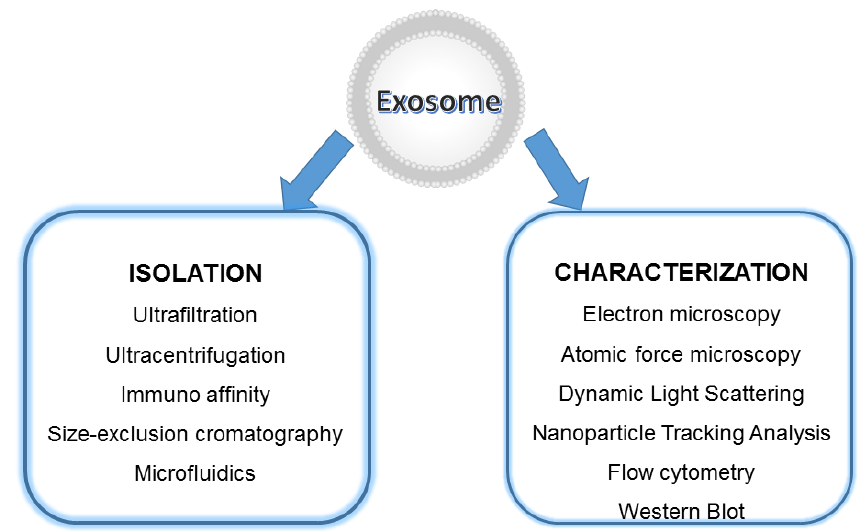
Figure 10. Isolation and characterization techniques for exosomal